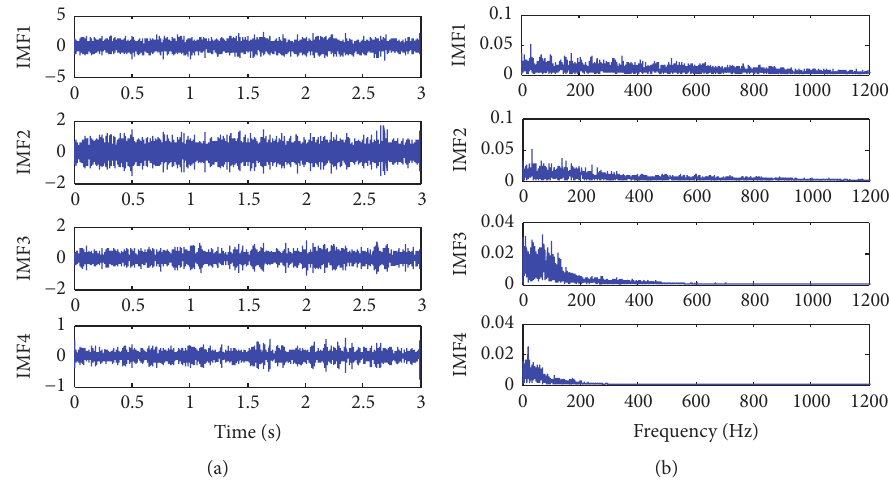
Figure 14: The IMF1 ∼ IMF4 of bearing inner race: (a) time-domain waveform; (b) frequency spectrum.